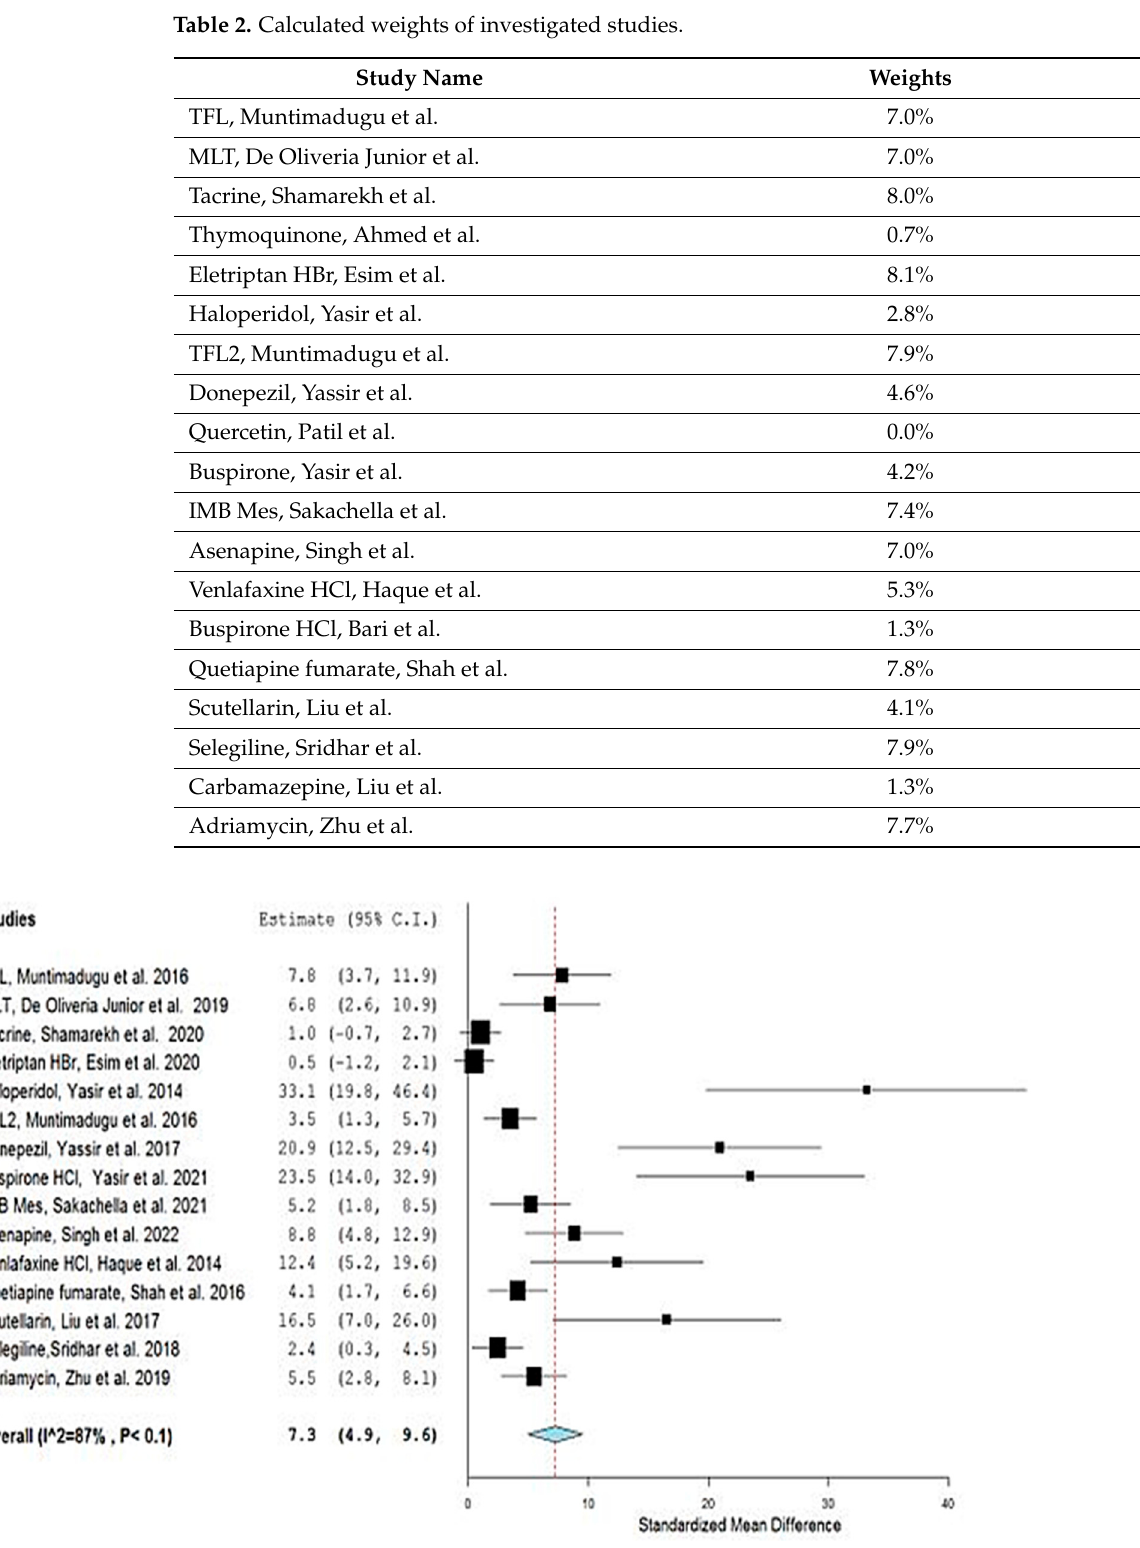
Figure 4. Forest plot of optimized meta-analysis for the studies: [1–3,5–8,11–17,19], according to OpenMetaAnalyst software.